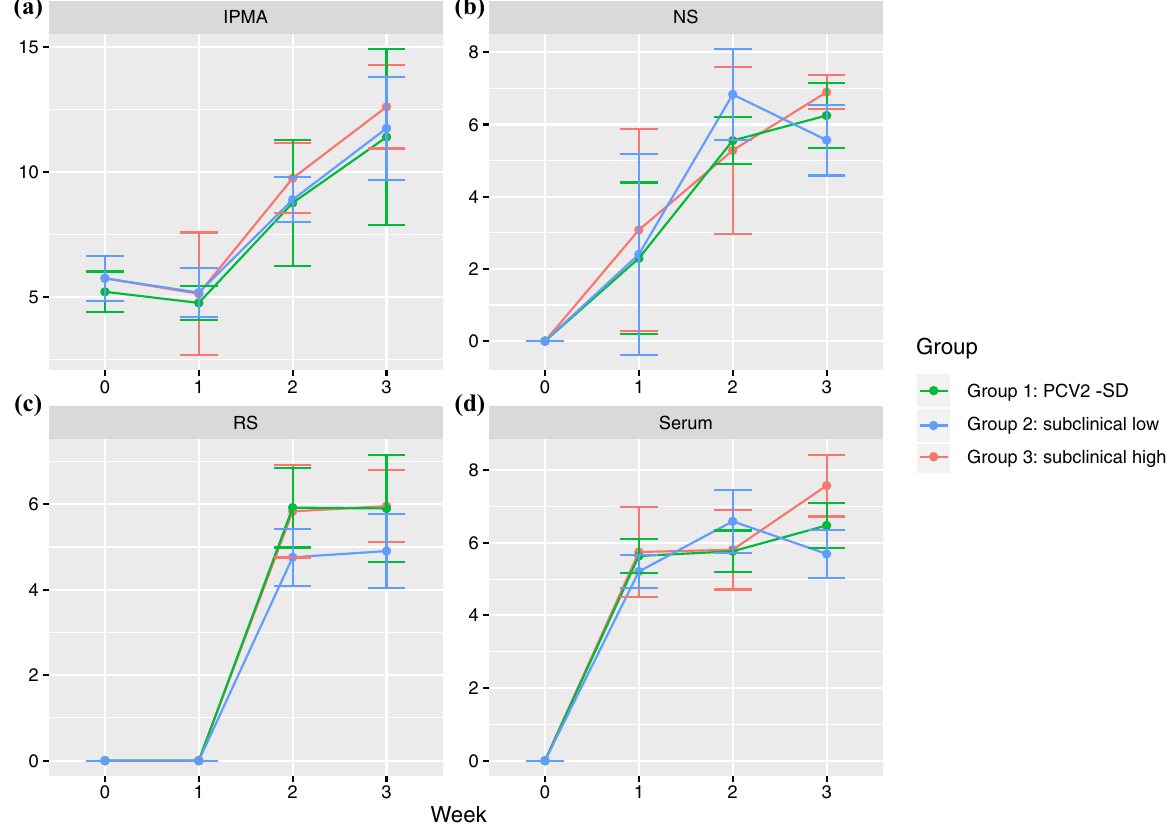
Figure 1. The average and 95% confidence intervals of log 2 antibody titers (IPMA) measured in sera ( a ) and